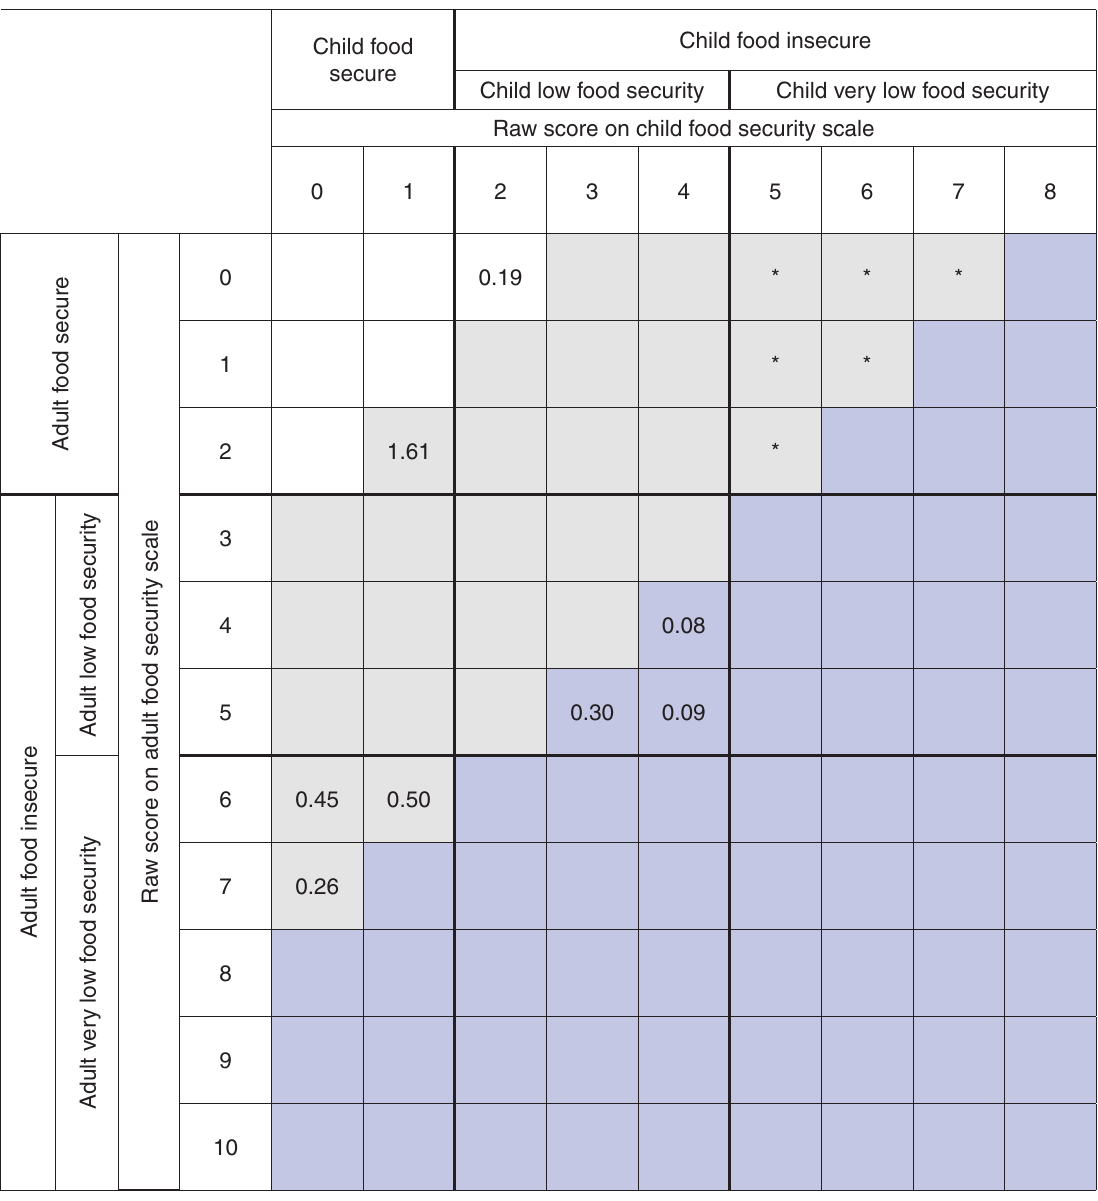
Table 1 Percentage of households with children, by raw score on the adult and child food security scales, average